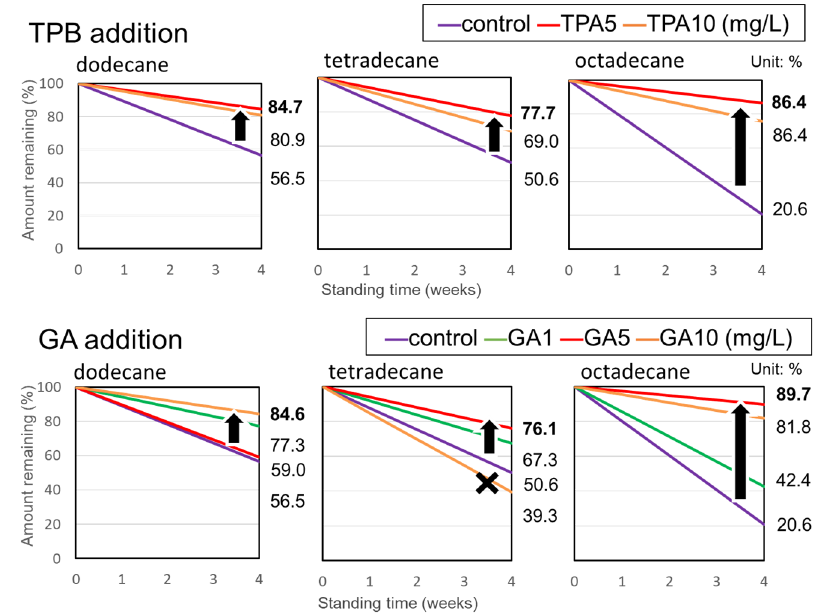
Figure 5. Changes in the amount of citral.